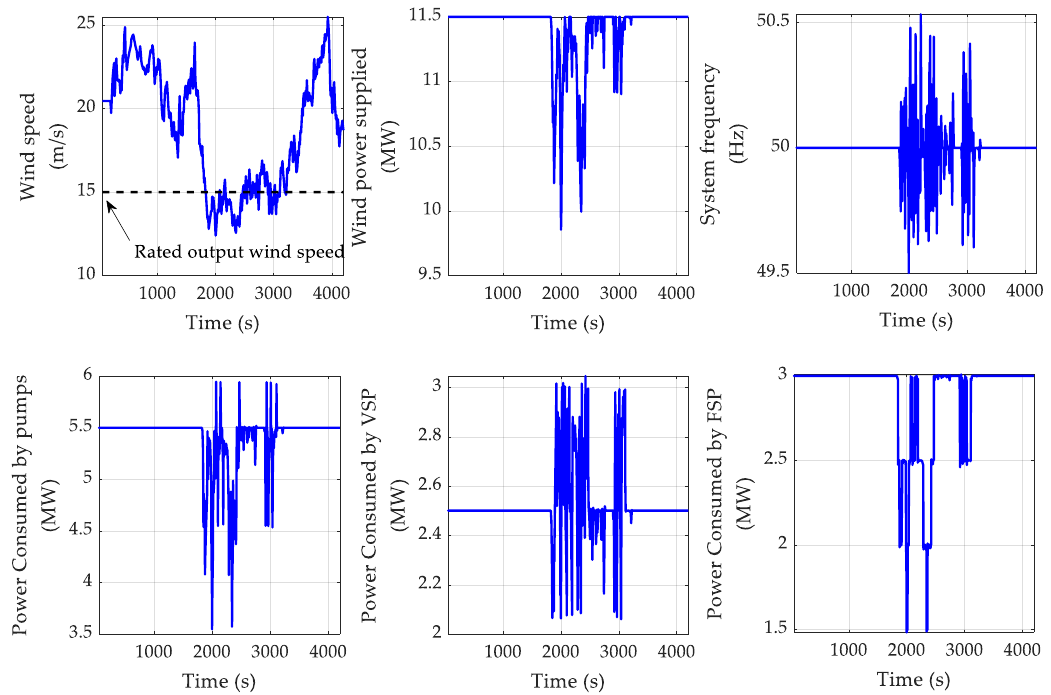
Figure 8. System frequency and power supplied and demanded when a wind speed fluctuation is simulated.